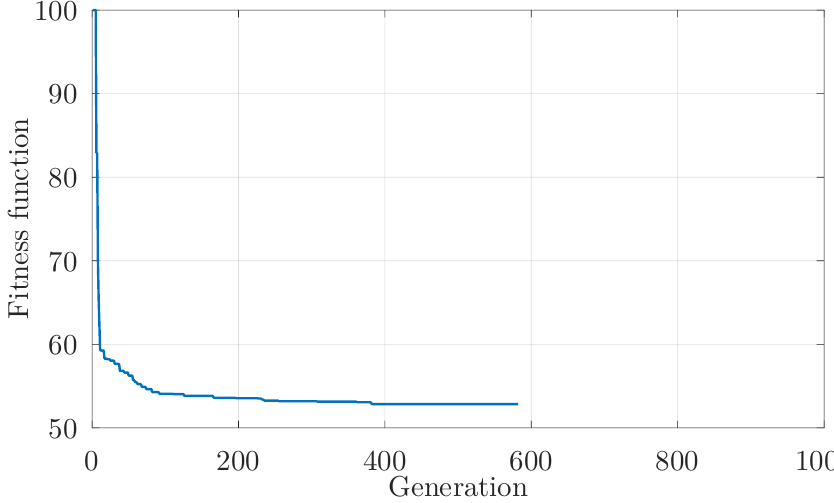
Figure 14. Change of penalty value (score) in reference to generation.